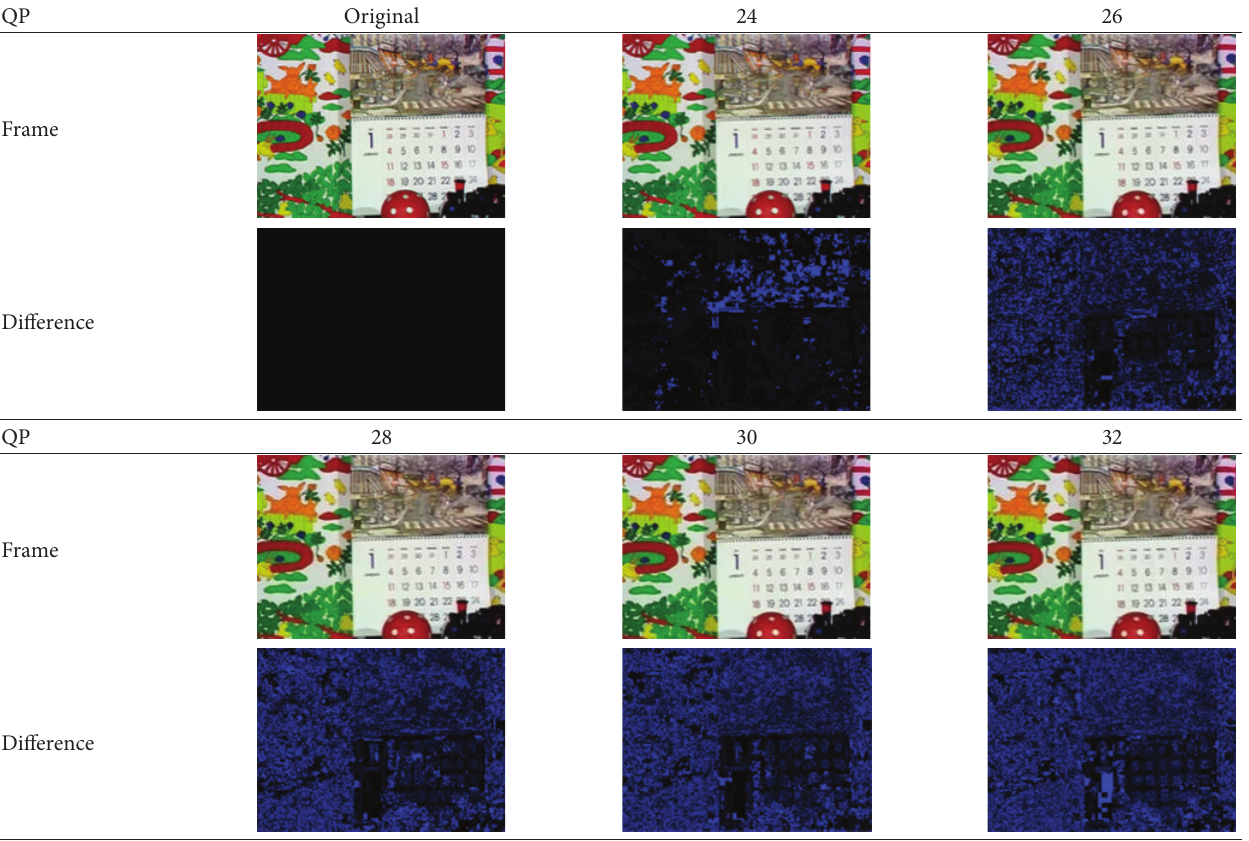
Table 6: Frame difference with different compression rates.